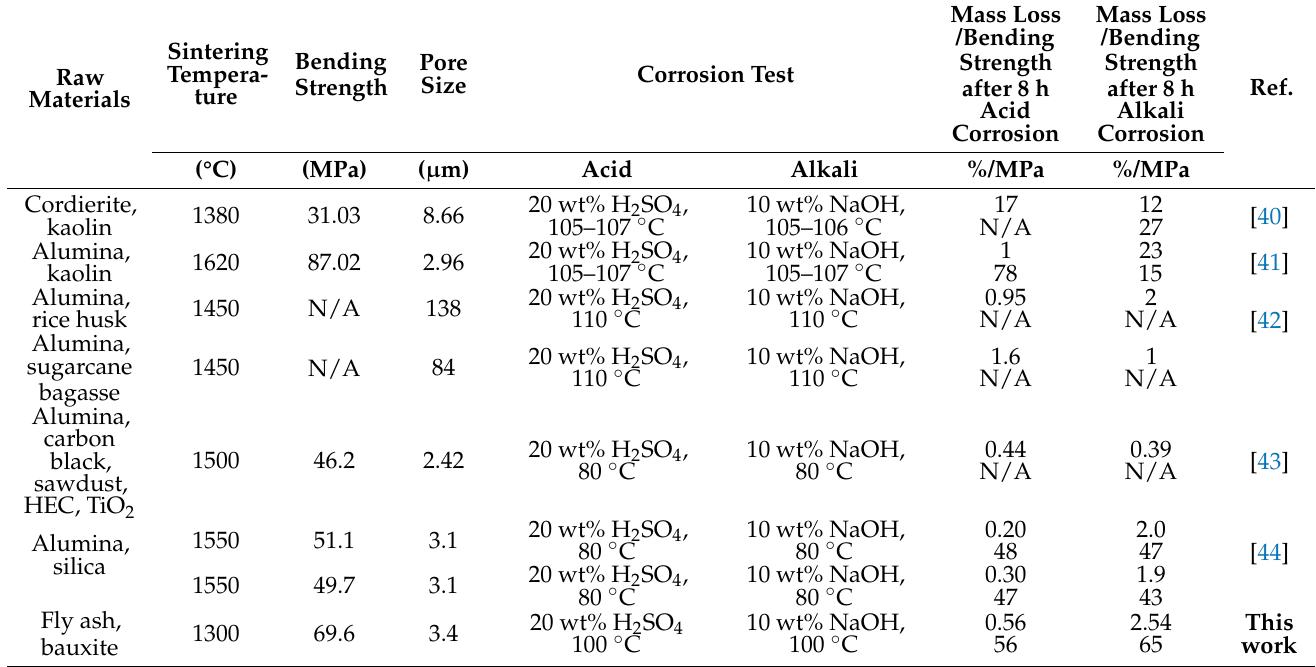
Table 3. Comparison of corrosion resistance between the supports fabricated in this study and existing